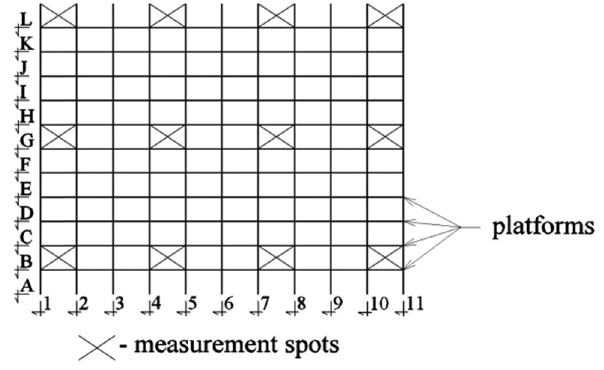
Figure 1: An example of a sca ff old scheme with marked measure - ment